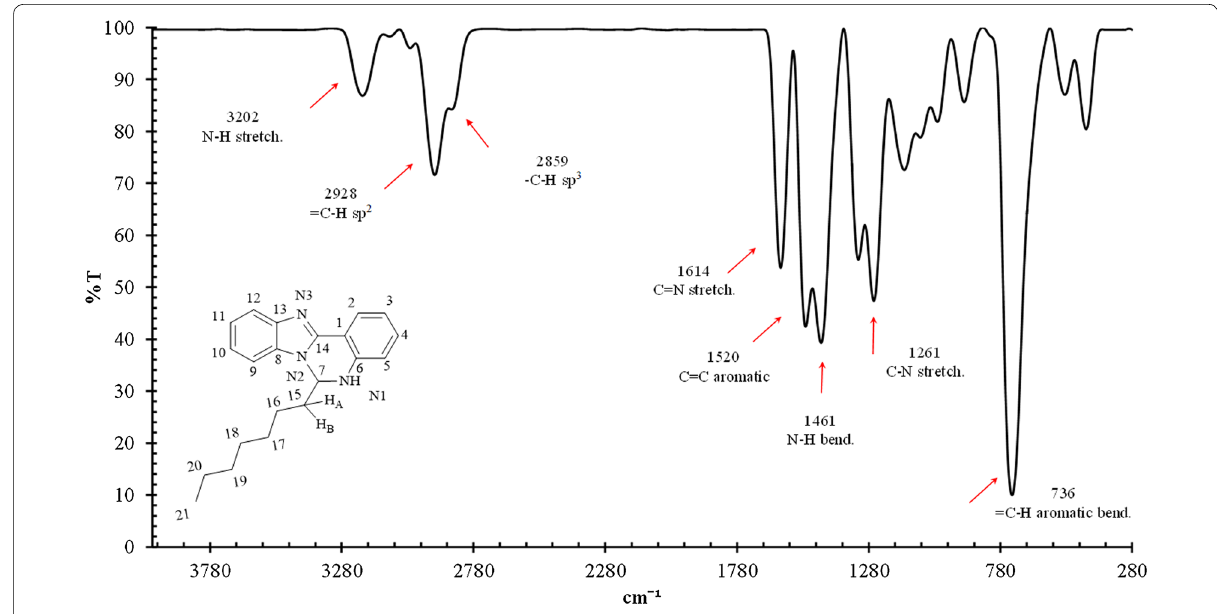
Fig. 4 FTIR spectrum of OCT